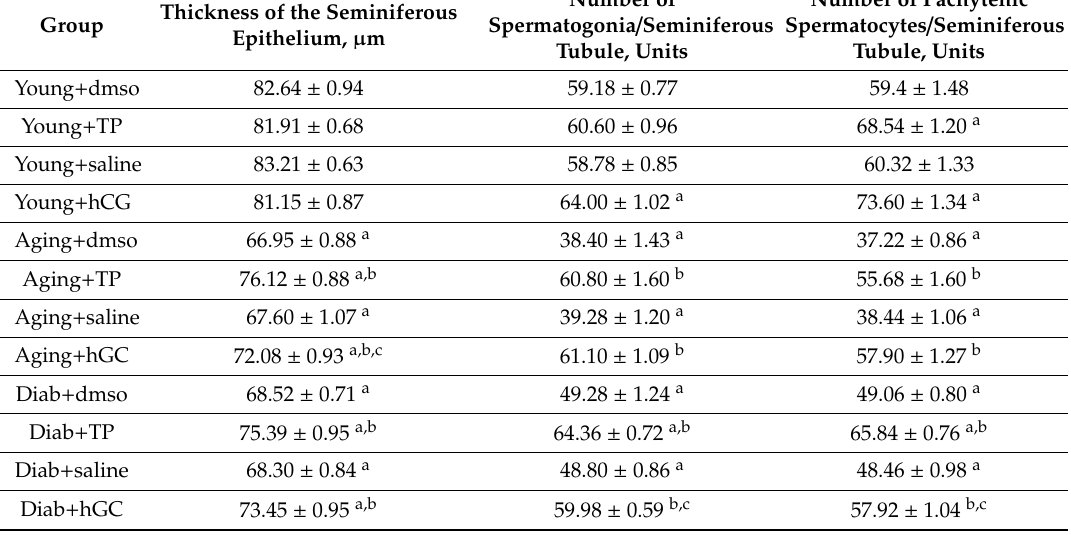
Figure 7. The morphology of the seminiferous tubules in the testis of diabetic rats, and the effect of five-day treatment with TP4/2 and hCG. A —Diab+dmso, B —Diab+TP, C —Diab-saline, D — Diab+hCG. The histology of the rat testes was evaluated using the staining of the testis section with Ehrlich hematoxylin and Eosin G. Scale bars, 100 μ m. Table 3. The effect of five-day treatment of young adult, aging and diabetic rats with TP4/2 and hCG on the thickness of the seminiferous epithelium and the number of germ cells in the seminiferous tubules.